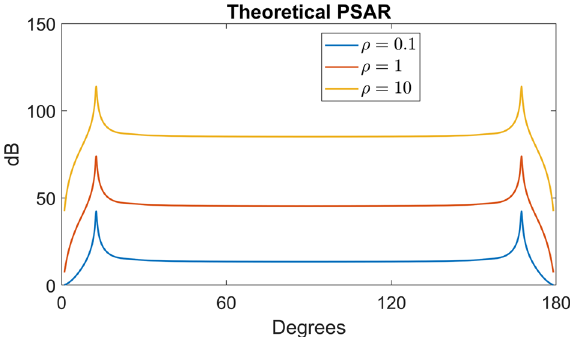
Fig. 6 Theoretical PSAR obtained for a generic triplet line array using different values of the ratio ρ = σ i /σ